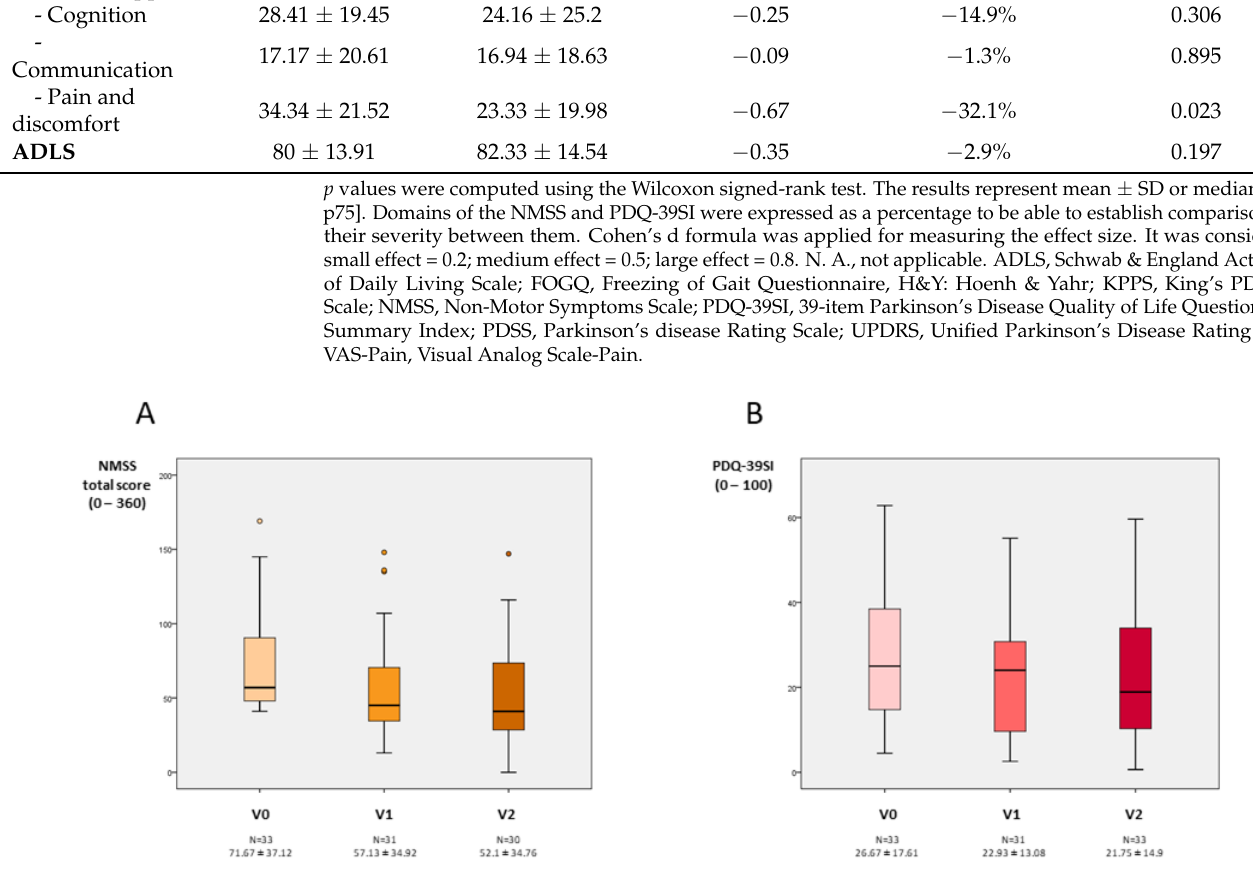
Figure 1. ( A ). NMSS total score at V0 (baseline), V1 (2 months ± 15 days), and V2 (6 months ± 30 days). V2 vs. V0, p = 0.002; V1 vs. V0, p = 0.001; and V2 vs. V1, p = 0.202. ( B ). PDQ-39SI at V0, V1, and